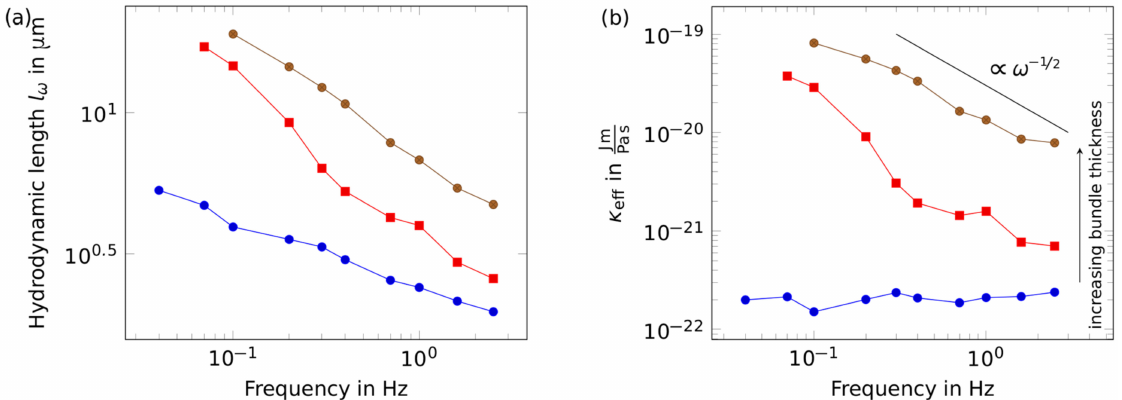
Figure 3. Rheological response of a successively thickened bundle. ( a ) While comparably thin bundles (blue circles) obey the predictions determined by the wormlike chain model, thicker bundles (intermediate: red squares, thick: brown circles) deviated from the ω − 1 / 4 -scaling, which translates into a frequency-dependent bending stiffness ( b ). With more and more bundles merged, the bending stiffness increased. At the same time, the bundles stiffened markedly for lower